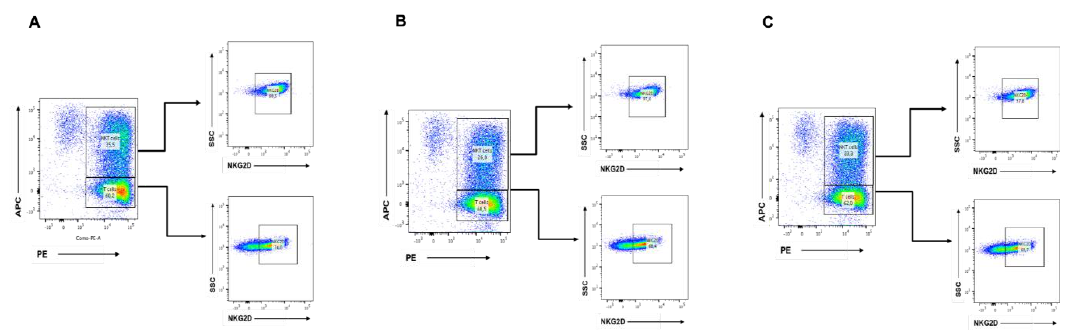
Figure 6. ( A ) The differential expression of the natural killer group 2 member D (NKG2D) receptor in the main cell subsets of human CIK cells, i.e., CD3+ T lymphocytes (CD4+ and CD8+) and CD3+CD56+ NKT cells: The surface NKG2D expression was evaluated. The CIK cells were immunophenotyped at day 14 by flow cytometry. In the untreated, both T lymphocytes subsets CD3+ T lymphocytes 60.2% and CD3+CD56+ NKT 35.5% showed high expressions of NKG2D receptor 74% and 98.5%, respectively. ( B ) In the untreated CBD 10 µM, both T lymphocytes subsets CD3+ T lymphocytes 68.5% and CD3+CD56+ NKT 26.8% showed high expressions of NKG2D receptor 68.4% and 97%, respectively. ( C ) In the DMSO control, both T lymphocytes subsets CD3+ T lymphocytes 62% and CD3+CD56+ NKT 33.3% showed high expressions of NKG2D receptor 69.7% and 97.8%, respectively.